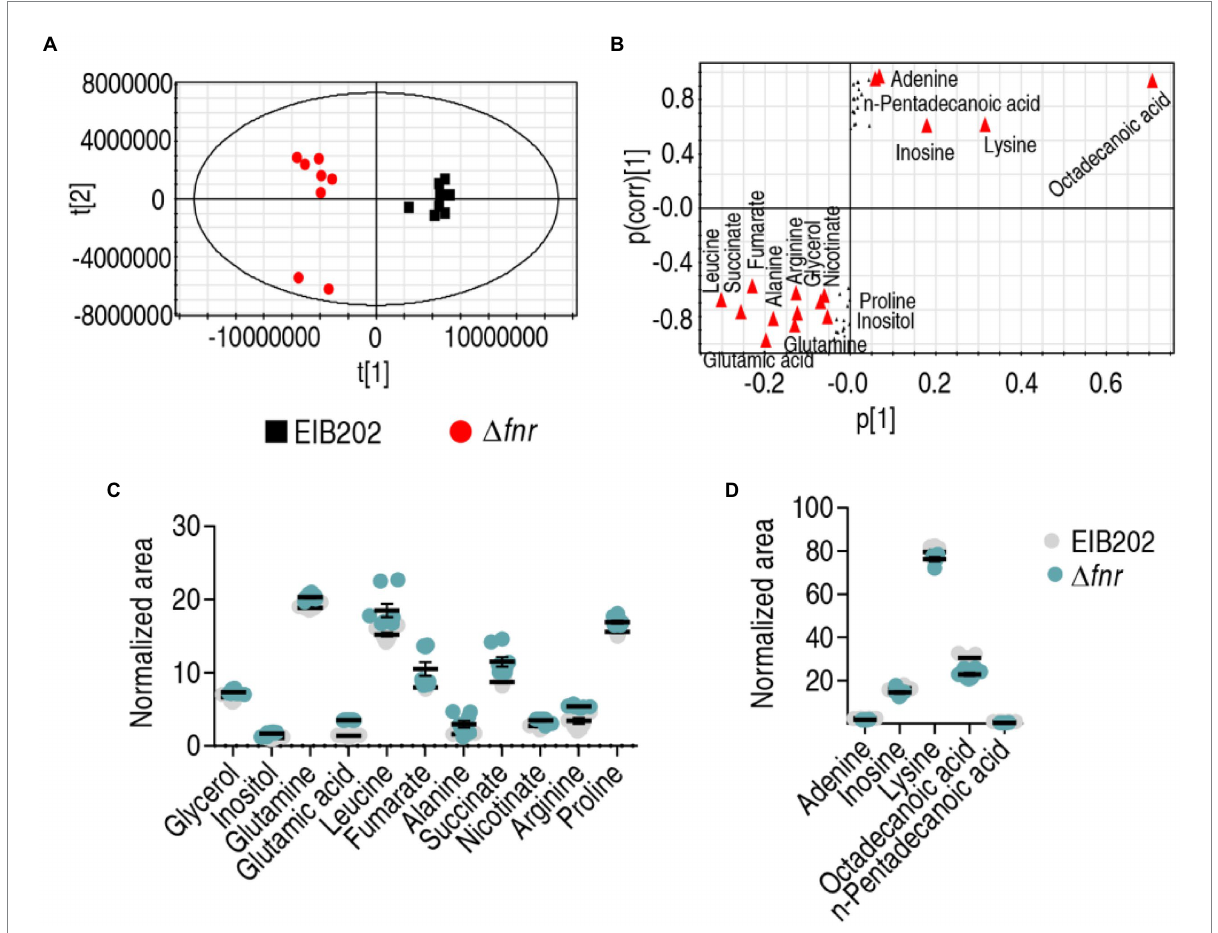
FIGURE 4 Identification of crucial metabolites. (A) The PCA analysis of EIB202 and Δ fnr . Each dot represents the technical replicate of samples in the plot. (B) S-plot generated from OPLS-DA. Predictive component p[1] and correlation p(corr)[1] differentiate Δ fnr from EIB202. The triangle represents metabolites in which candidate biomarkers are marked. (C) and (D) Scatter diagram of 16